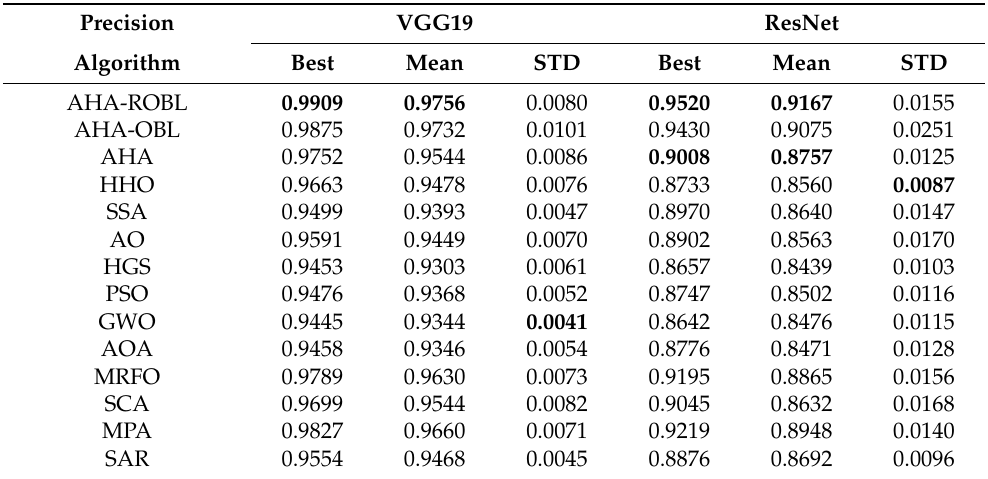
Table 5. Comparison of the performance of deep feature models of the AHA-ROBL with other recent optimizers versus avg.